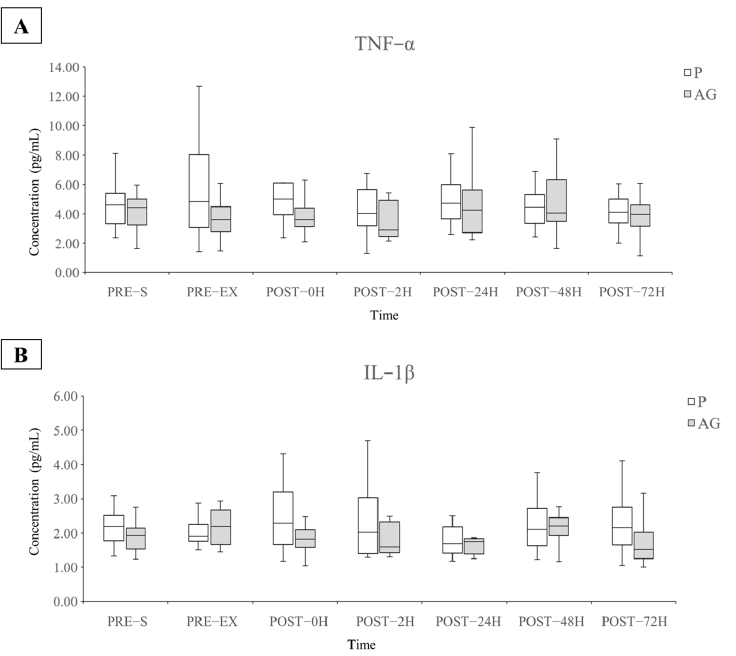
Figure 4. Levels of plasma TNF- α and IL-1 β during the experimental period ( N = 12). Q1, median, Q3, minimum, and maximum values of TNF- α (A) and IL-1 β (B) are presented in boxplots. AG: American ginseng; IL-1 β : interleukin-1 β ; P: placebo; TNF- α : tumor necrosis factor- α .